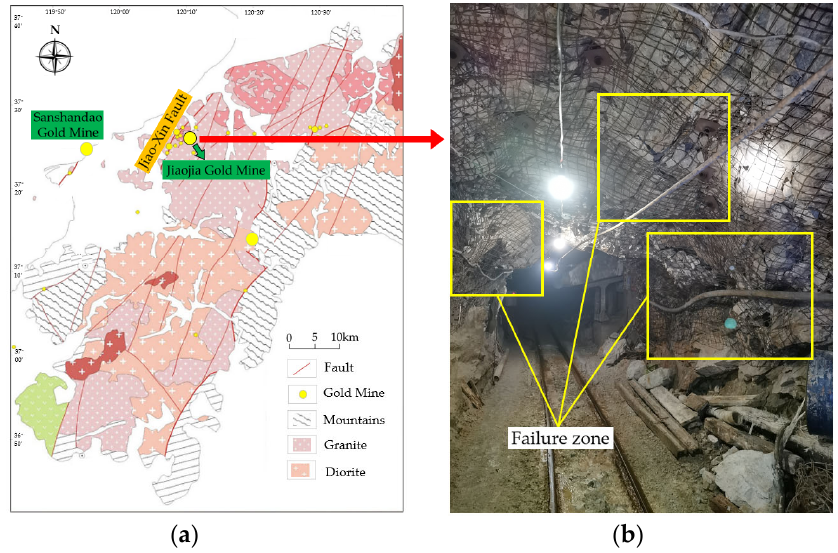
Figure 1. Jiaojia Gold Mine in Jiaodong Peninsula. ( a ) Geological conditions of the Jiaojia Gold Mine; ( b ) failure zone of the roadway under the influence of the Jiao ‐ Xin fault.